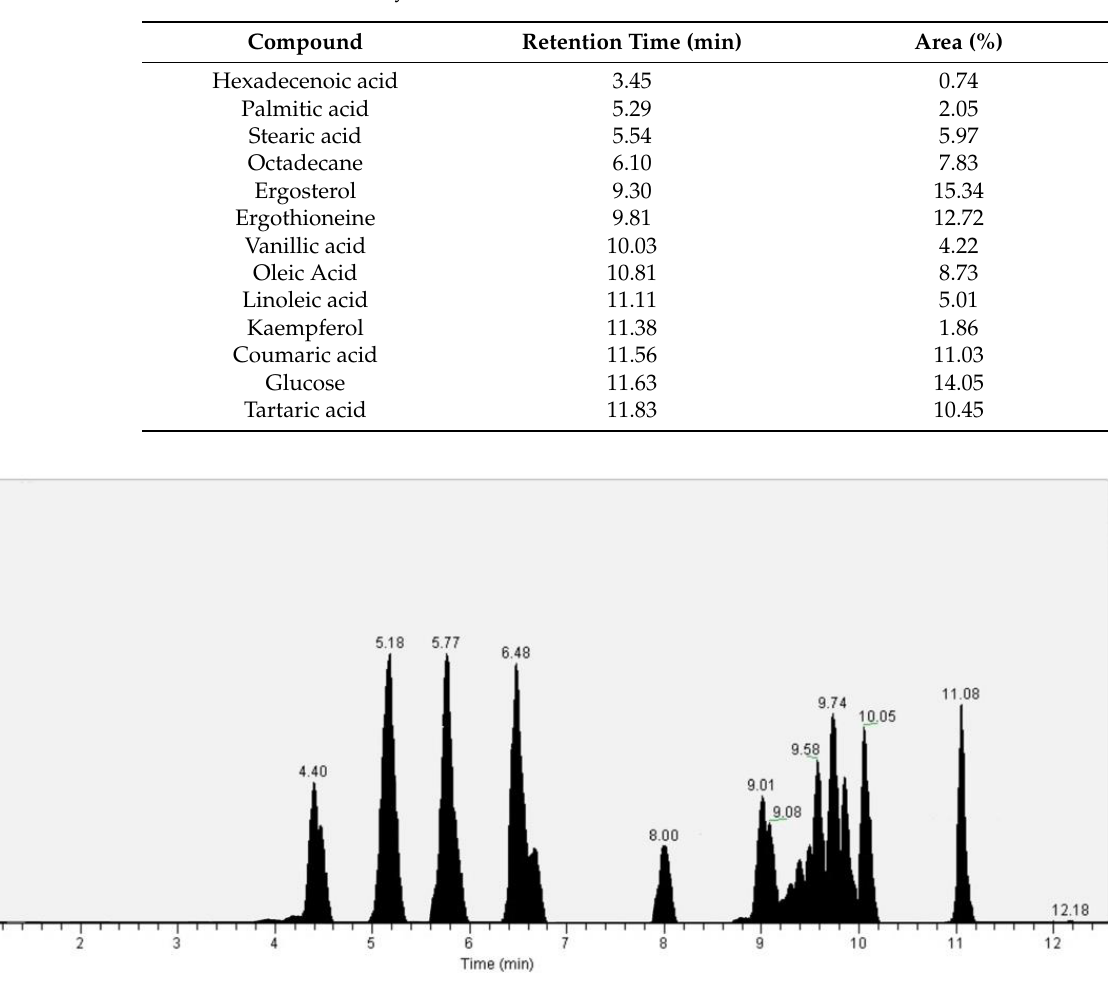
Figure 19. LC–Orbitrap-MS of Hericium erinaceus.